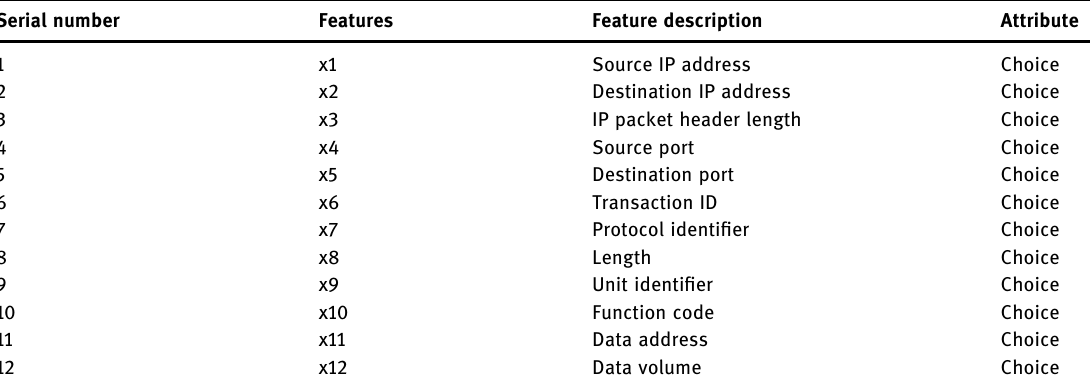
Table 1: Characteristic quantity of network communication behavior selection Serial